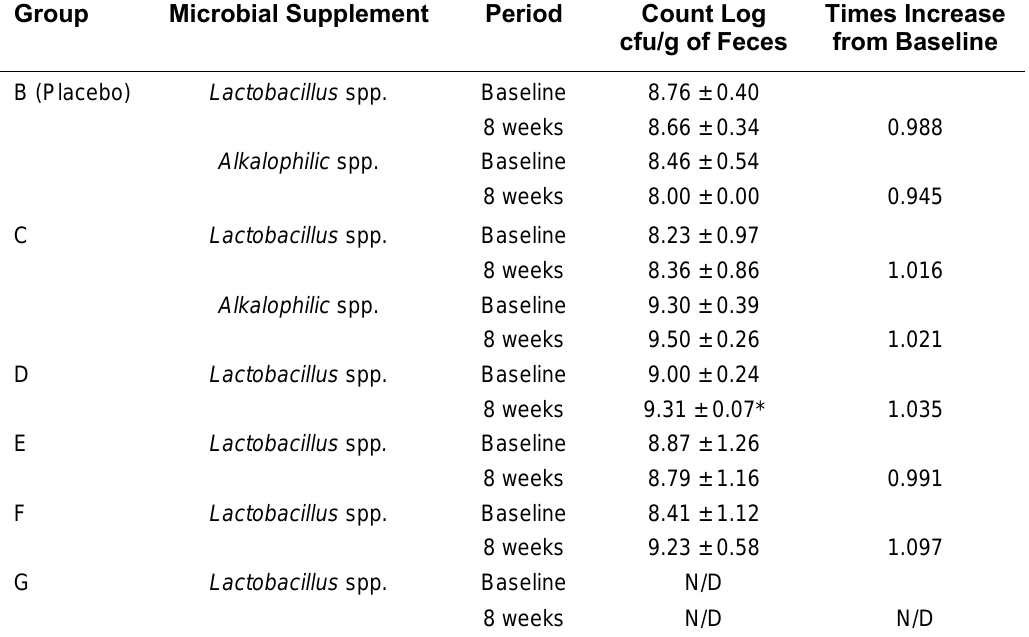
Effect of Probiotic Formulation on Lactobacillus spp. and Alkalophilic spp. Before